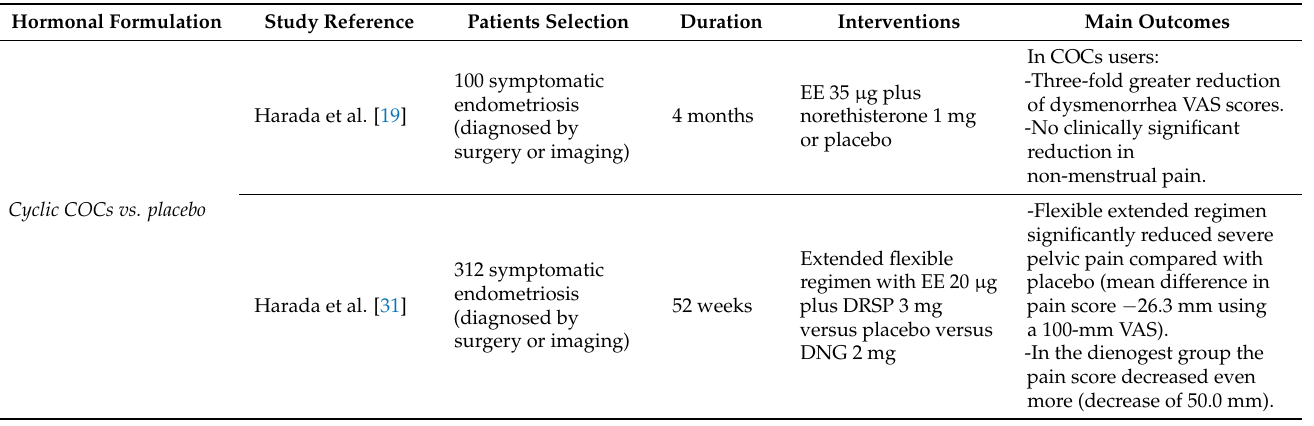
Table 1. Estrogen-progestin and endometriosis. Summary of studies comparing COCs with placebo, GnRH agonists, oral progestins, long-acting progestins and NSAIDs. Hormonal